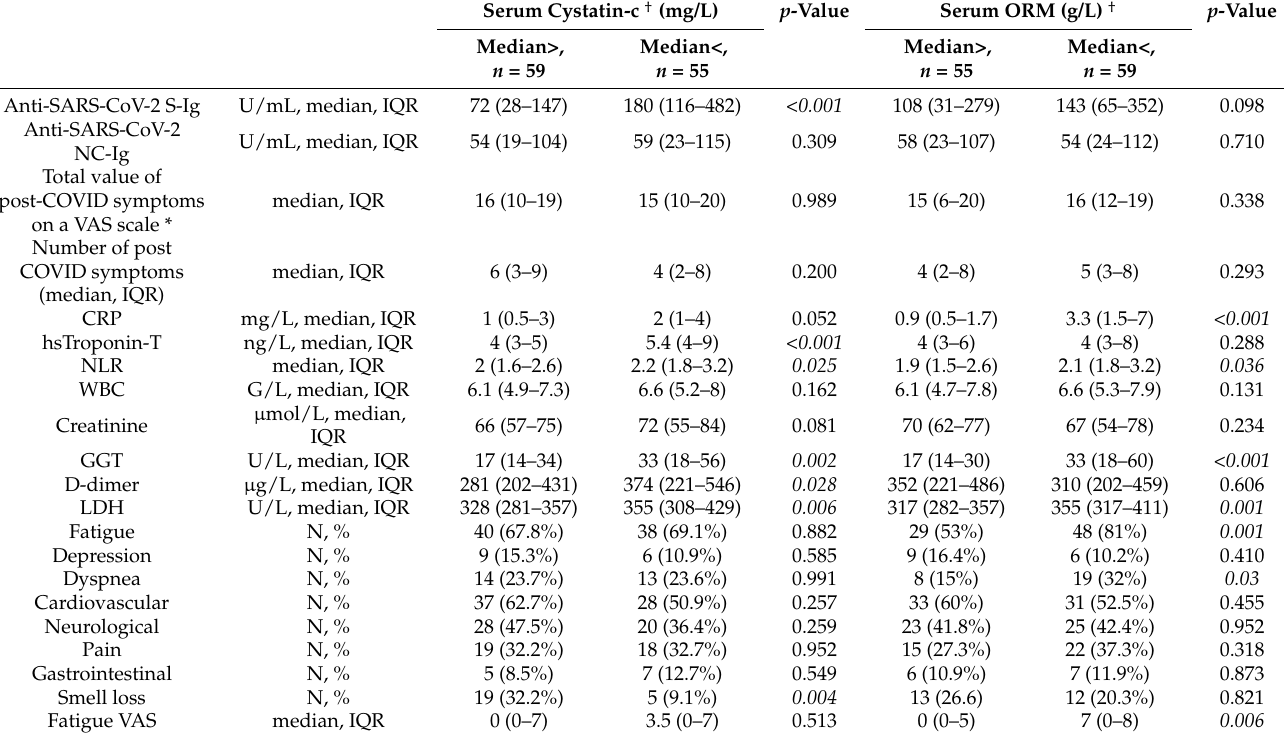
Table 2. Associations of median serum cystatin-c and orosomucoid concentrations measured in long-COVID patients with variables measured and collected on follow-up visit.